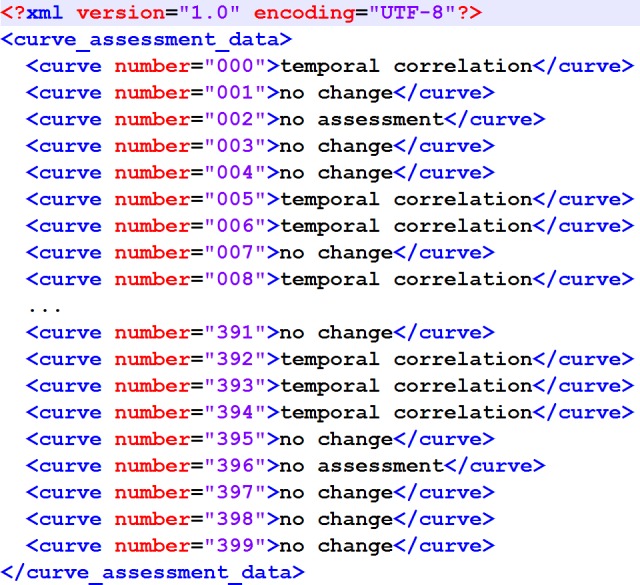
XML structure of the output XML.It matches the original proposal from Newe et al. (2015).